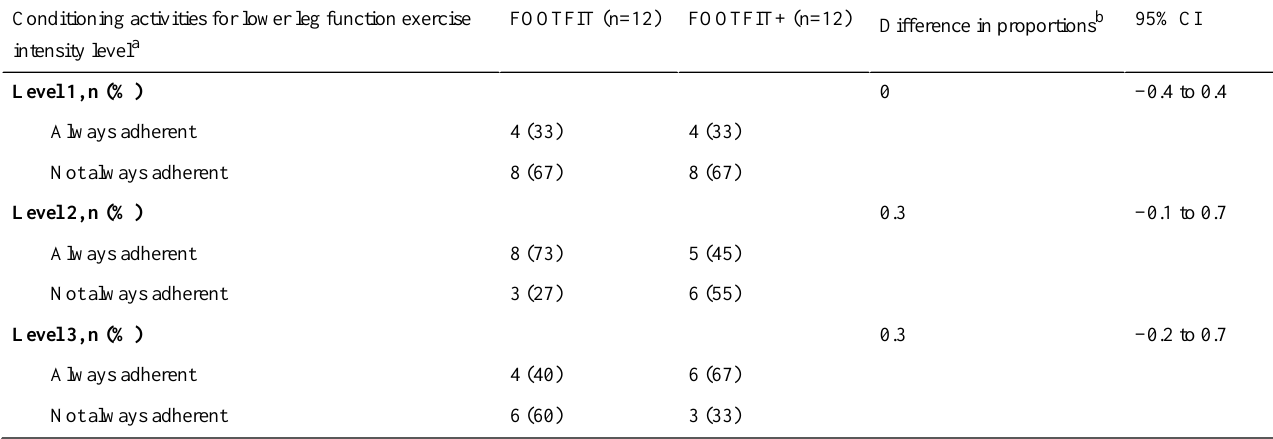
Table 3. Frequency distribution for adherence across all exercises by the level of intensity for FOOTFIT and FOOTFIT+